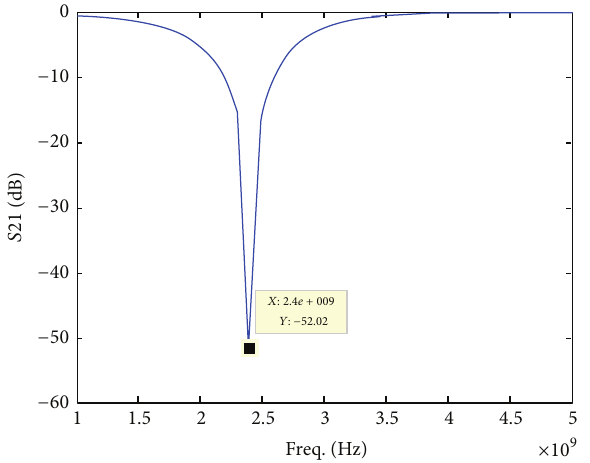
Figure 7: The variation of S21 versus frequency calculated using the ABCD Matrix approach from the equivalent circuit model.